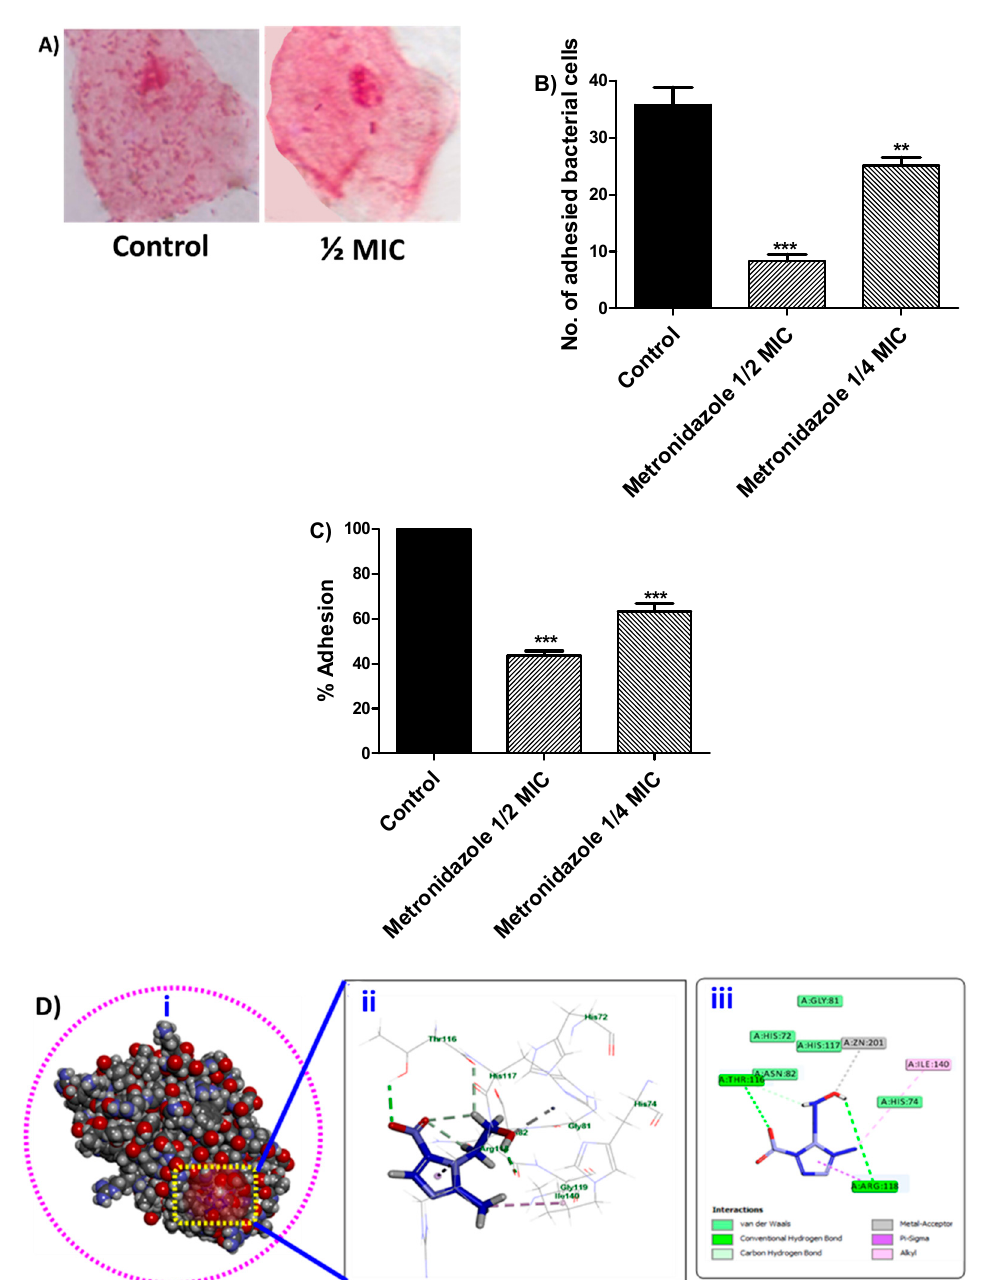
Figure 4. Effect of metronidazole in sub-MIC on P. mirabilis adhesion. ( A ) Adhesion to epithelial cells: epithelial cells from urine of pregnant were cocultured with P. mirabilis treated or untreated with metronidazole in ½ MIC or ¼ MIC. ( B ) Metronidazole significantly reduced the number of adhered bacterial cells to epithelial cells ( p < 0.0001 and 0.0095 for ½ MIC or ¼ MIC, respectively). ( C ) Adhesion to abiotic surface: P. mirabilis was cultured in presence or absence of metronidazole in ½ MIC or ¼ MIC, incubated at 37 °C for 60 min. The adhered cells were crystal violet stained and their optical densities were measured at 590 nm. Significantly, metronidazole reduced the bacterial adhesion ( p < 0.0001). One-way ANOVA test was used to compare between the metronidazole in ½ MIC or ¼ MIC treated and untreated bacterial cultures. The data were expressed as mean ± standard error of percentage change from untreated cultures; and were considered statistically significant when p values < 0.05. ( D ) Interactions of metronidazole into the active site of P. mirabilis adhesin MrpH (PDB: ID 6Y4F): ( i , ii ) three dimensional and ( iii ) two dimensional interactions. ** = p < 0.01, *** = p < 0.001.